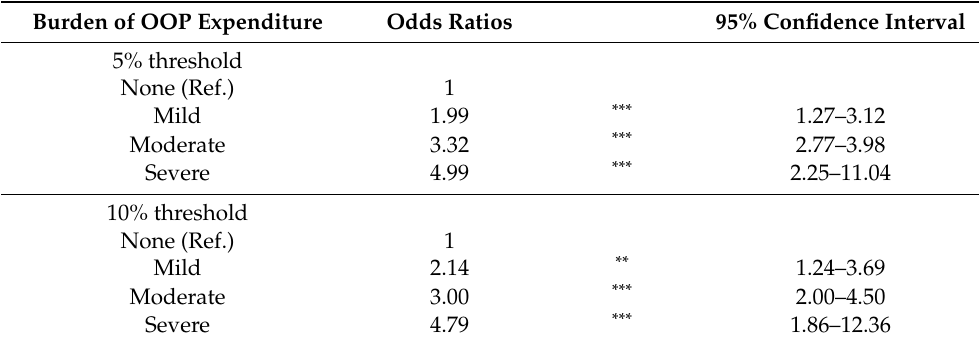
Table 6. Logistic regressions—Disability and high burden of OOP health